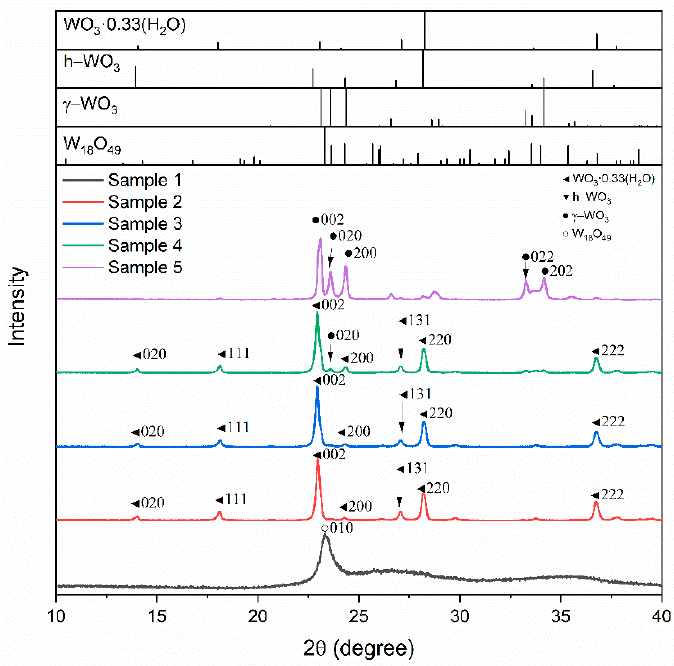
Figure 2. XRD data of samples 1–5 (see details in Table 1). For comparison: the top inset is the standard reference diffraction patterns of W 18 O 49 (JCPDS no. 36-0101), h-WO 3 (JCPDS no. 75-2187), WO 3 ·0.33(H 2 O) (JCPDS no. 87-1203), and γ -WO 3 (JCPDS no. 32-1295).